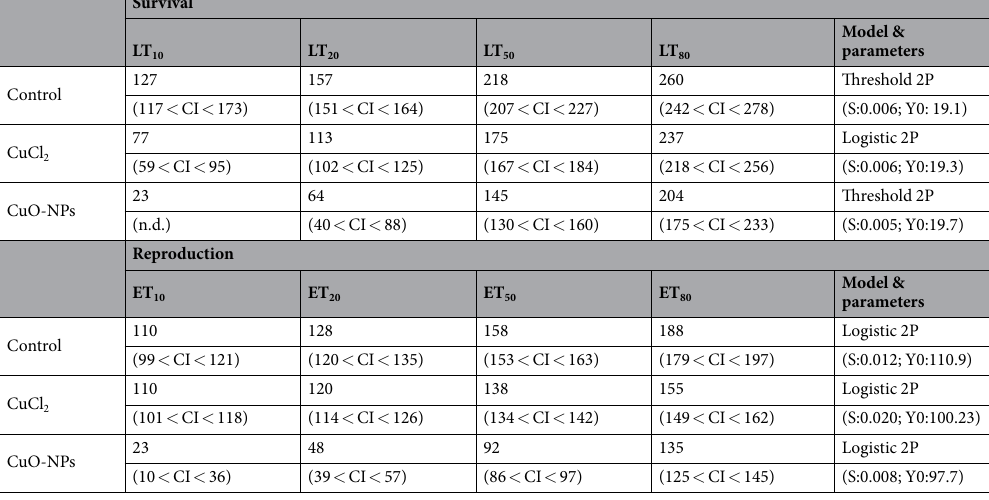
Table 2. Summary of the Effect Time (ETx) for survival (LTx) and reproduction for Enchytraeus crypticus when exposed to Cu (1400 and 180 mg Cu/kg DW soil for CuO-NPs and CuCl 2 , respectively) in LUFA 2.2 soil. n.d. = not determined. 95% Confidence Intervals (CI) are shown in